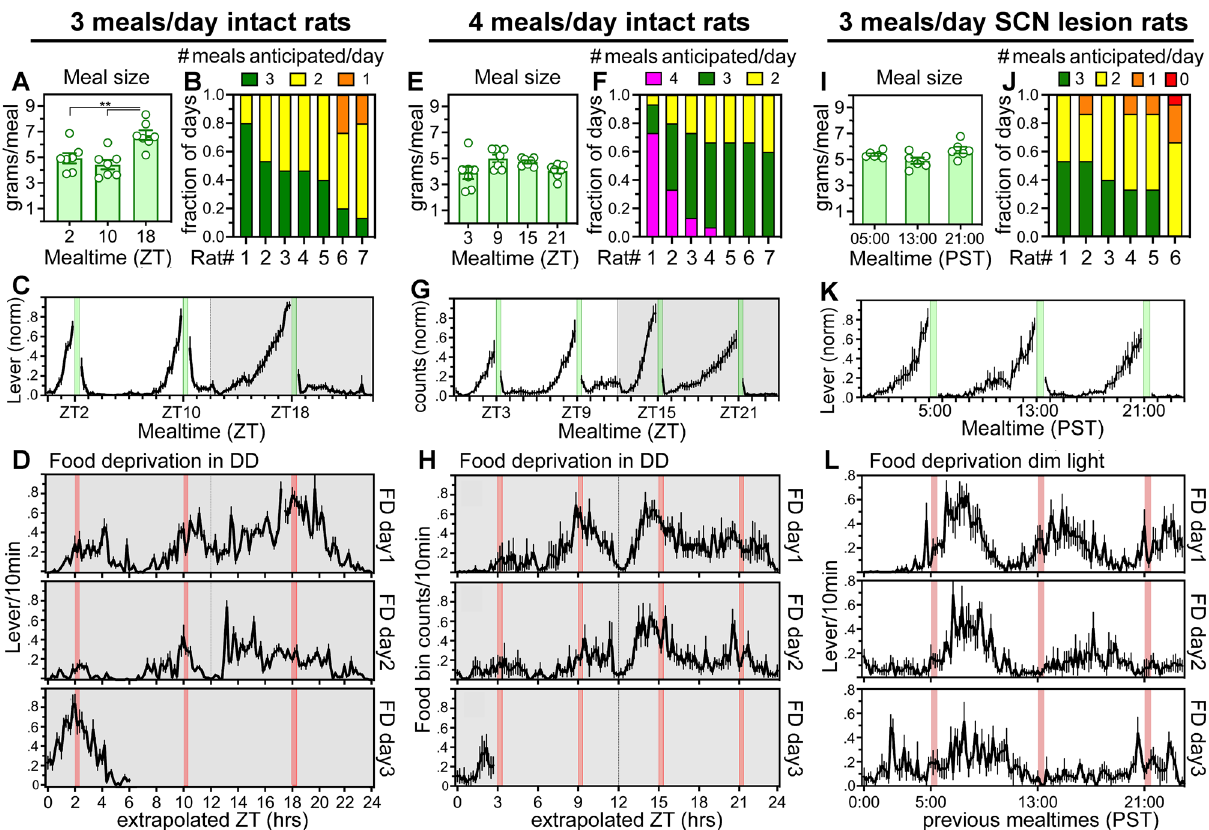
Figure 2. Group mean food intake and food anticipatory activity in rats provided 3 or 4 daily meals. ( A – D ) Intact rats on 3-meal schedule. ( E – H ) Intact rats on 4-meal schedule. ( I – L ) SCN-ablated rats on 3-meal schedule. ( A , E , I ) Group mean (± SEM) grams food consumed at each mealtime. Significant differences between mealtimes, * p < .001. ( B , F , J ) Fraction of food restriction days that each rat anticipated 1, 2, 3 or 4 meals (number of daily meals anticipated color coded; red = 0, orange = 1, yellow = 2, green = 3, fuscia = 4). ( C , K ) Group mean (± SEM) activity waveforms of lever counts/10 min during the last week of restricted feeding. Mealtimes are denoted by vertical green bars. Operant responses during mealtime were excluded before data normalization and averaging across rats. ( G ) Group mean (± SEM) activity waveforms of operant nose pokes/10 min during the last week of restricted feeding. ( D , H , L ) Group mean (± SEM) activity waveforms during the food deprivation days in constant dark ( D , H ) or constant dim light. ( L ) Food deprivation days 1–3 are aligned vertically. Expected mealtimes denoted by vertical red